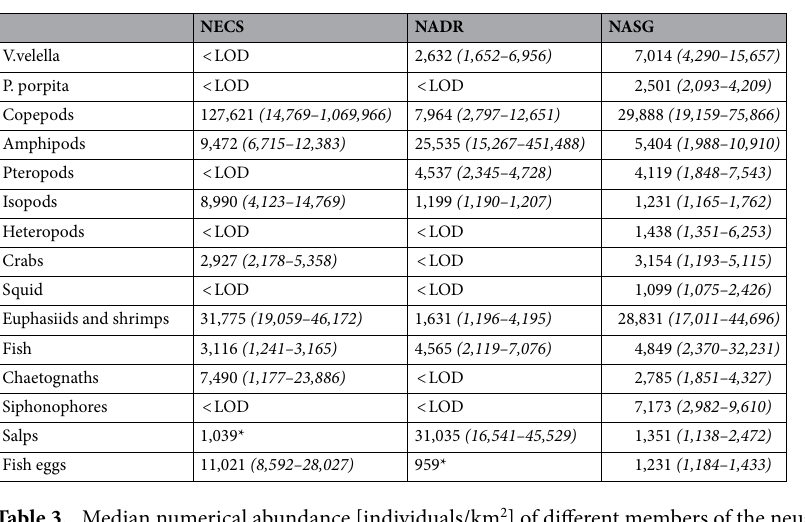
Table 3. Median numerical abundance [individuals/km 2 ] of different members of the neuston observed in surface waters of the Northeast Atlantic Continental Shelves (NECS), the North Atlantic Drift Region (NADR) and the North Atlantic Subtropical Gyre (NASG), respectively. *Based on one value only (i.e., species was only found in one out of n samples). Values in parentheses refer to the 25th and 75th percentiles. LOD limit of detection (average: 1 ′ 174 individuals/km 2 for all Manta trawl deployments, range: 959–1 ′ 504).